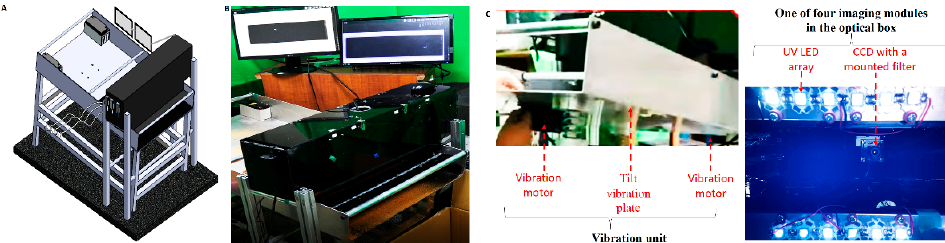
Figure 1. Proposed HMC workstation consisting of an optical box with black shielding, a vibration unit, and two monitors: ( A ) schematic and ( B ) photograph. ( C ) Photos of a vibration unit and an imaging module inside the optical box.